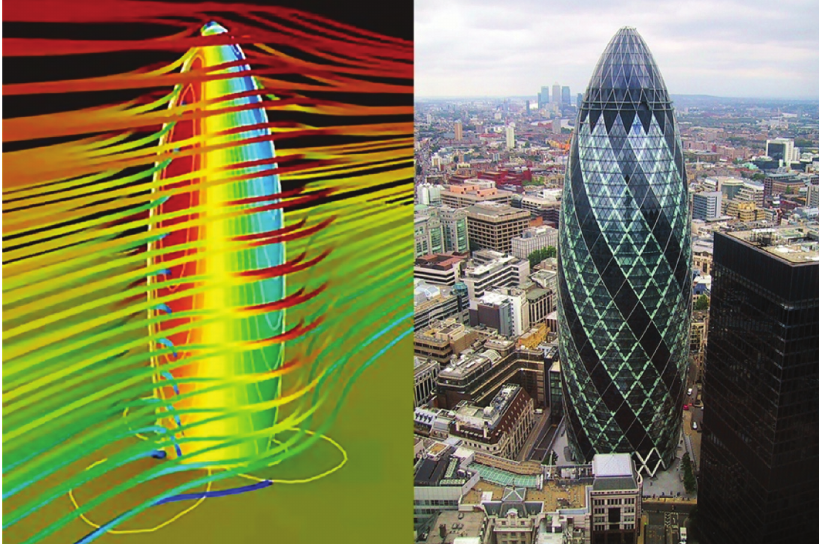
Figure 4. (a) Shaped by nature. The computational model of the Swiss Re showed that a cylindrical shape responds better to air currents than a square one and reduces whirlwinds © Foster+Partners (b) Image use granted under Wikimedia Commons